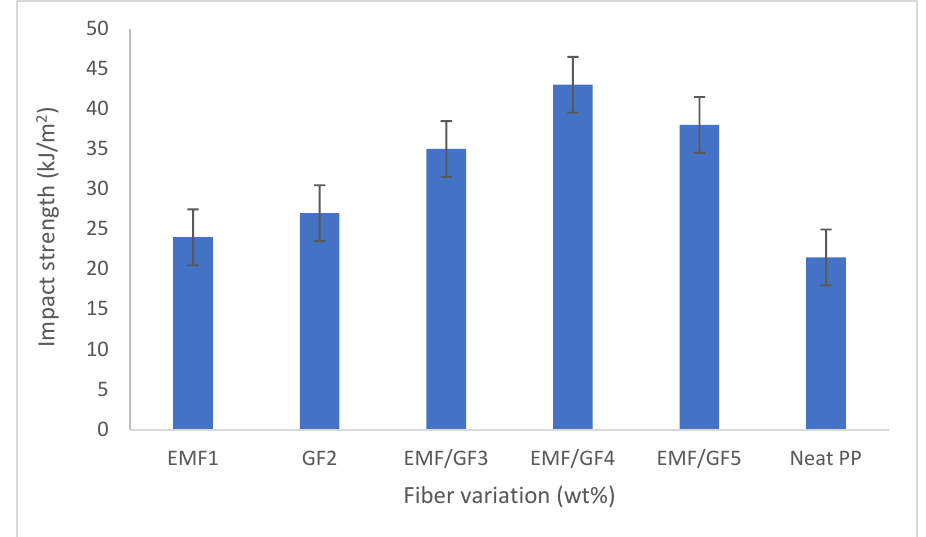
Figure 9. Impact strength of single and hybrid composites.